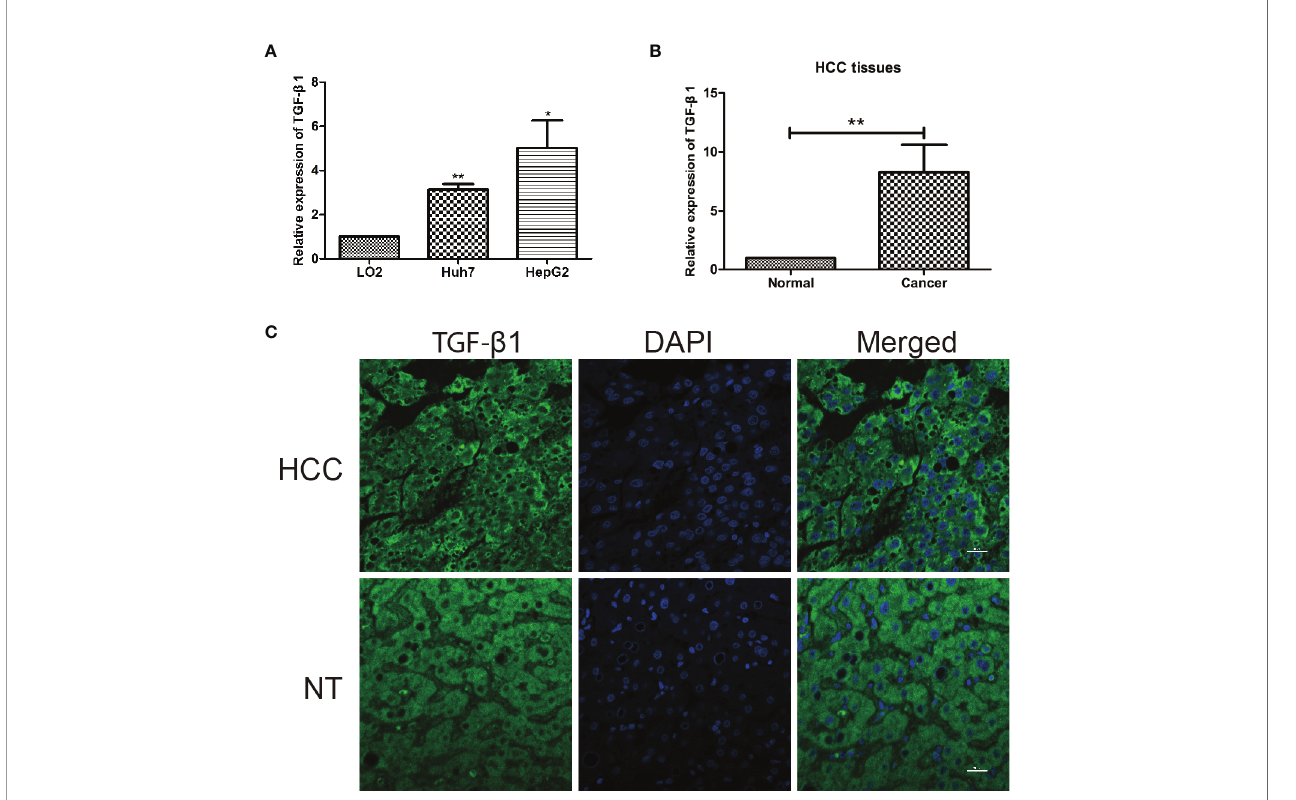
FIGURE 5 | TGF- b 1 is highly expressed in HCC cell lines and tissues. (A) Relative mRNA expression of TGF- b 1 in normal human hepatic cell line (LO2) and two human HCC cell lines (Huh7 and HepG2). TGF- b 1 gene expression is shown as the mean ± SD of three independent experiments. (B) Relative mRNA expression of TGF- b 1 in HCC tissues is signi fi cantly higher than that in the paired neighboring non-tumor tissues. TGF- b 1 gene expression is shown as the mean ± SD of fi fteen tissue pairs. b -ACTIN was used as an internal control in RT-qPCR (** p < 0.01, Student ’ s t -test). (C) Microscopic images show liver cross-sections of paired para- and cancerous biopsies. TGF- b 1 protein level (green) was visualized by indirect immuno fl uorescence staining, while nuclei DNA (blue) by DAPI staining. The images are representatives from three pairs of HCC and non-tumorous neighboring tissues. HCC, hepatocellular carcinoma; NT, neighboring non-tumorous tissue from the same HCC patient. *P <